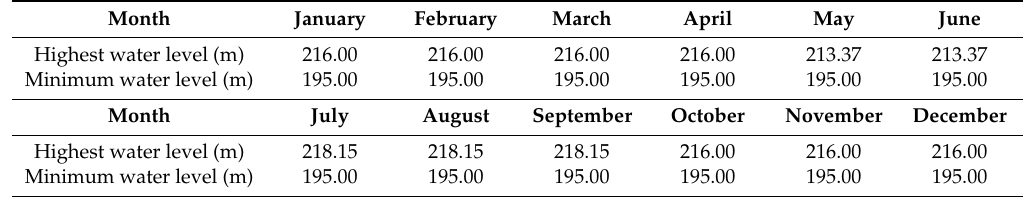
Table 1. The control water level of Nierji reservoir in di ff erent